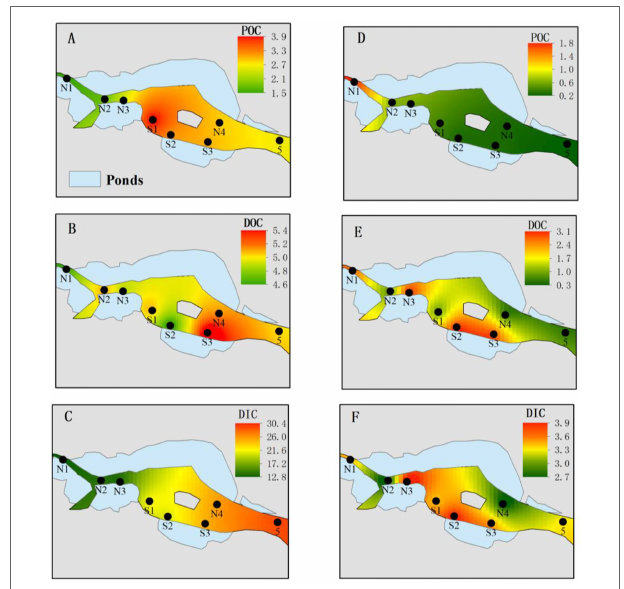
FIGURE 3 | Spatial distribution of various carbons in ZJE during the flood (A–C) and dry (D–F) seasons. (A, D) Particulate organic carbon (POC; mg/L); (B, E) dissolved organic carbon (DOC; mg/L); (C, F) dissolved inorganic carbon (DIC;